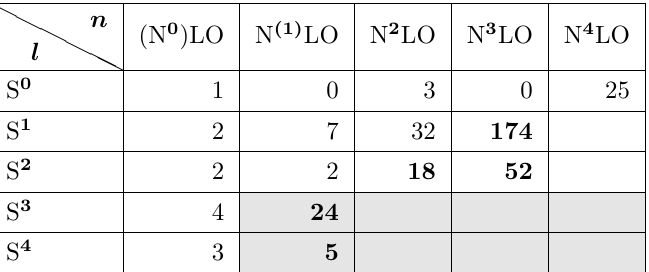
Table 1 . The complete state of the art of PN orbital dynamics of generic compact binaries. The PN corrections enter at the order n + l + Parity ( l ) / 2 , with the parity 0 or 1 for even or odd l , respectively. The higher-order sectors with the entries in boldface have been uniquely addressed in [4, 5, 10, 13] and in the present work via the EFT of gravitating spinning objects [14]. The entries in the table indicate the loop computational scale within this framework, namely the number of highest-loop graphs in each sector. The sectors up to the current complete state of the art at the 4PN order, except the top right one, are available in the public EFTofPNG code at https: //github.com/miche-levi/pncbc-eftofpng